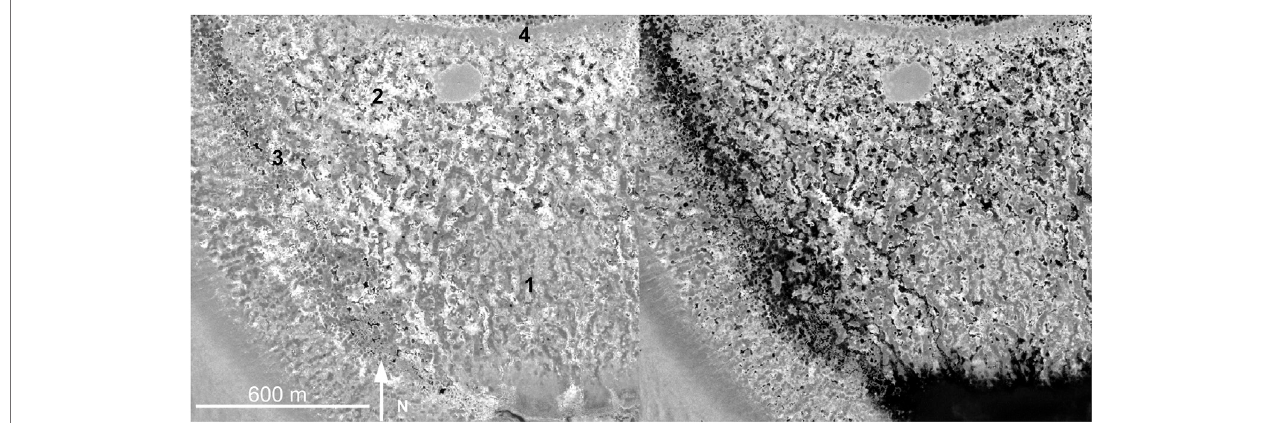
FIGURE 5 | Left: August 2019 Worldview image. Surface patterns in old drained thaw lake basins. 1: Ribbed pattern with sedge-lined diffuse drainage lines alternating with Betulanana heath (dark grey). 2. Area dominated by extensive Sphagnum growth and small thaw ponds. 3: Low and high centered polygons with pond formation by ice wedge thaw. 4. Stable low centered ponds in a younger basin (see also Supplementary Figure S4 ). Right: the same area with widespread fl ooding, July 2017. Location 2 of the image see Figure 4 at nr 3. WorldView © 2019 MAXAR.